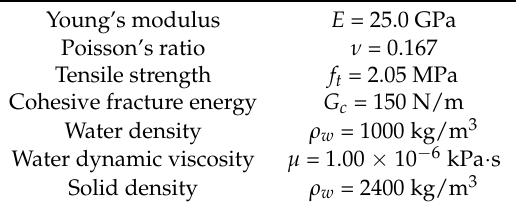
Table 3. Parameter of the concrete gravity dam.